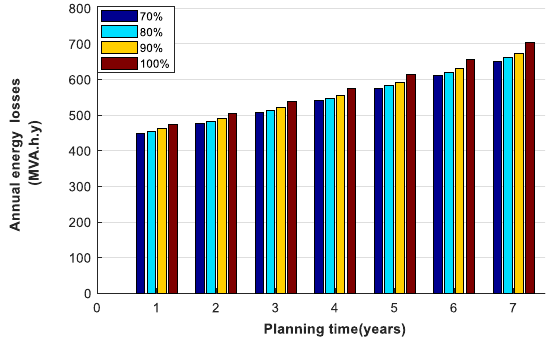
Figure 6. Annual energy losses obtained in the four proposed scenarios.